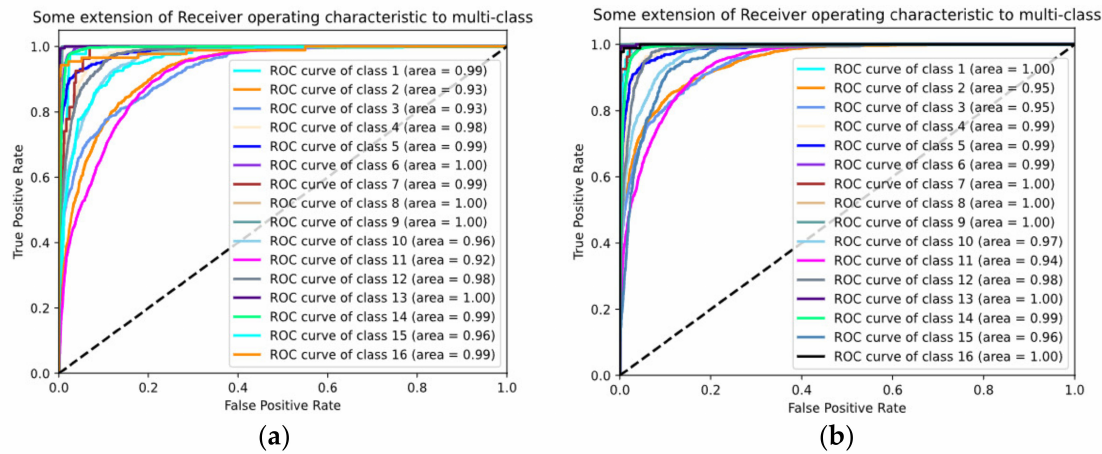
Figure 10. Comparison of ROC curve under Indian Pines 5% training data: ( a ) CNN spe ( b ) CNN SFMF